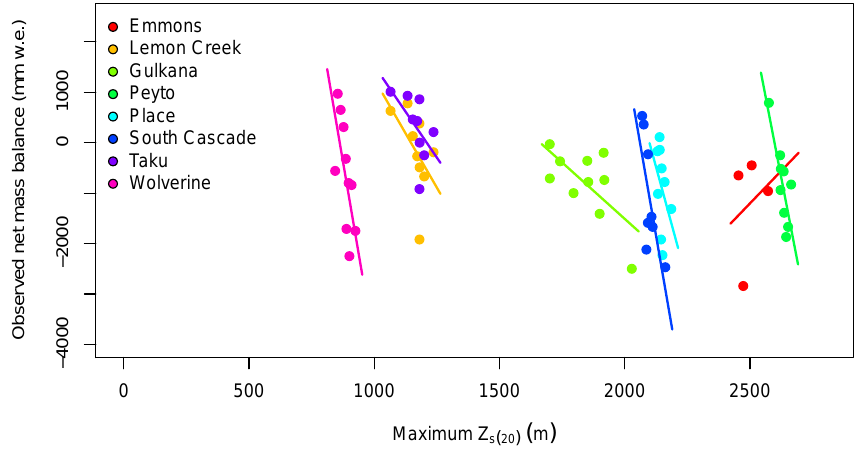
Fig. 9. ELA est versus observed net mass balance at eight index glacier sites, 2000–2009. MOD02QKM imagery illustrate the skill of the cluster anal- ysis method. While some classification errors exist on shaded slopes, the derived snow line metrics are similar. Future re- search should examine the glacier facies detection method presented here with the MODSCAG approach (e.g. Rittger et al.,